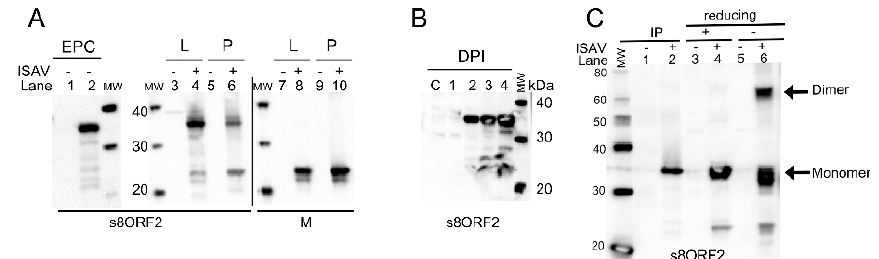
Figure 1. Western blots of lysates from EPC cells transfected with the s8ORF2 construct, ISAV